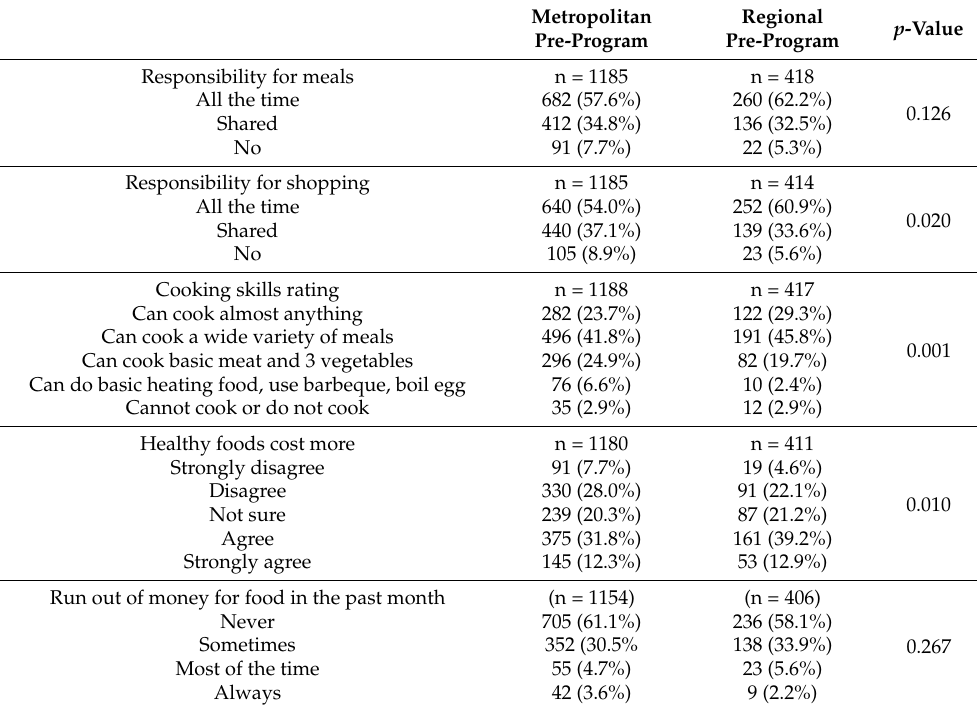
Table 4. Food literacy and dietary behaviours differences at